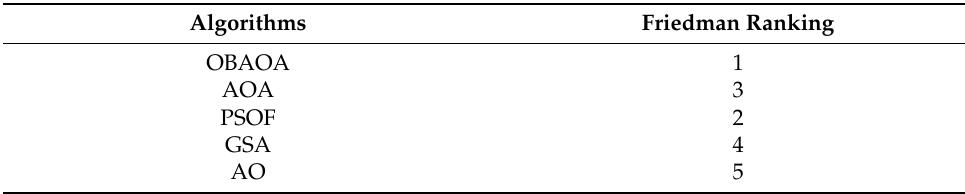
Table 8. Friedman ranking test for Ballard Mark V